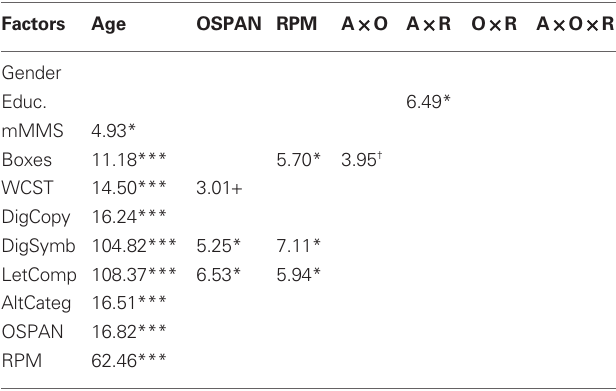
Table 2 | ANOVA on demographic and neuropsychological data – df (1, 50); only significant F s are shown.